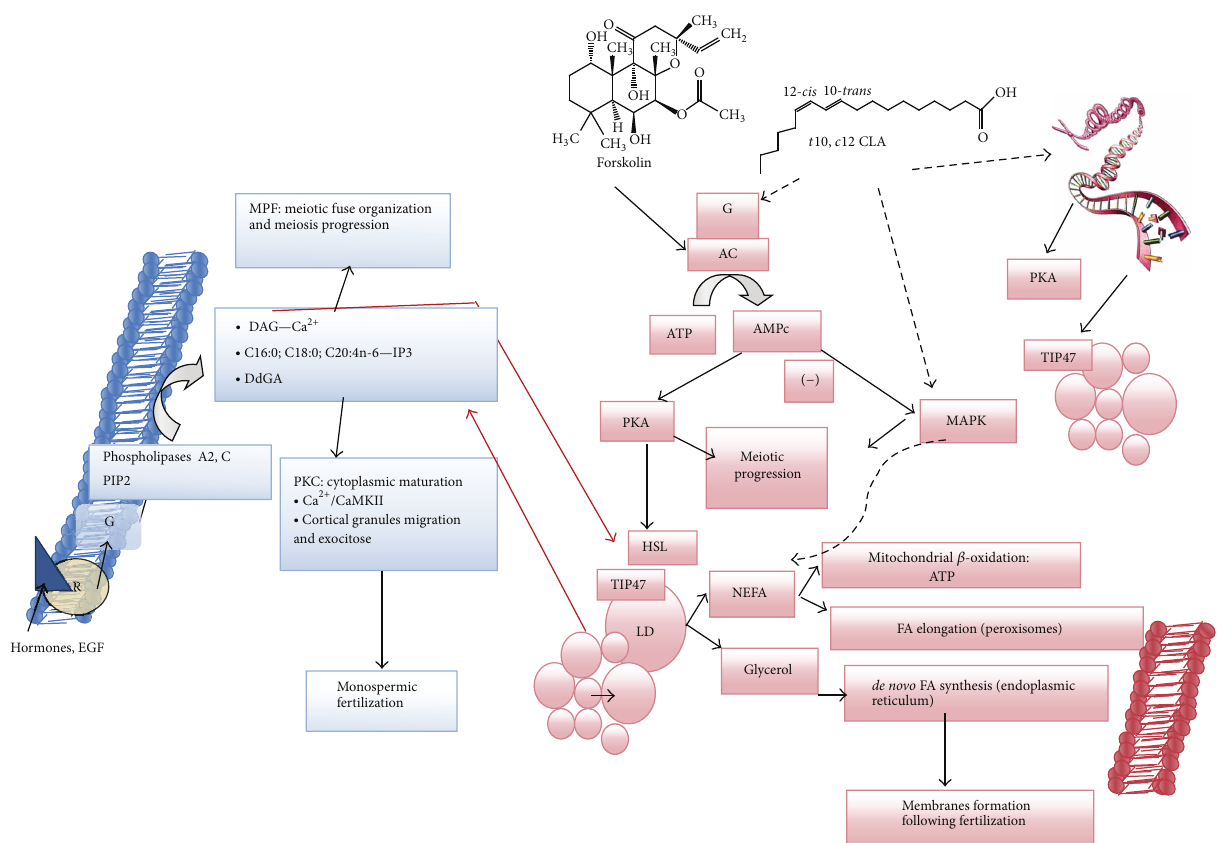
Figure 4: Hypothetical model for the effects of forskolin and trans -10, cis -12 conjugated linoleic acid (CLA) in the regulation of oocyte lipid metabolism and developmental competence acquisition: red colour and solid arrows, stimulation of cAMP intracellular levels, PKA and MAPK pathways by forskolin (see text for details); potential mechanisms of CLA action are also in red but illustrated by dashed arrows, including stimulation of PKA and MAPK pathways interfering with LD lipolysis, control of oocyte gene expression, and protein synthesis, namely, perilipins. Left, the cytoplasmic membrane and different events that are crucial for suitable oocyte maturation are represented in blue. R and G are the transmembrane G-protein-coupled receptor activated by different hormones or EGF (blue triangle) during this process. Red arrows illustrate the activity of different intracellular messengers and fatty acids regulating oocyte lipid metabolism and quality . DAG, diacylglycerol, DdGA, diradilglyceride, PIP2, phosphatidylinositol 4,5 bisphosphate, IP3, inositol 1,4,5-trisphosphate; PKA, protein kinase A; PKC, protein kinase C, MAPK, mitogen protein kinase; AC, adenylyl cyclase; HSL, hormone sensitive lipase; MGL, monoglyceride lipase; P, perilipin protein; LD, lipid droplet; NEFA, nonesterified fatty